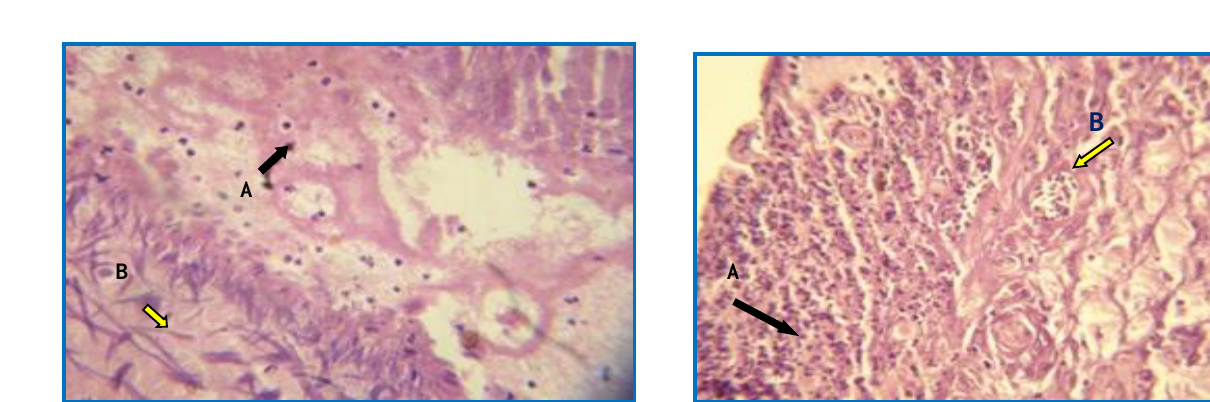
Figure, 6: There is necrotization of the epithelial layer of mucosa with neutrophils infiltration in subepithelial layer (A) and congested blood vessel with neutrophils in their lumen (B). Group A, post seven days (H and E40X)